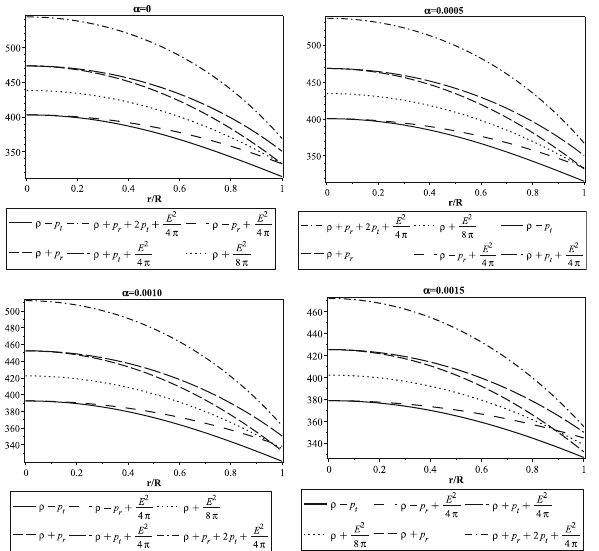
Fig. 5 Variation of energy conditions with the radial coordinate r / R for LMC X − 4 due to different chosen values of α